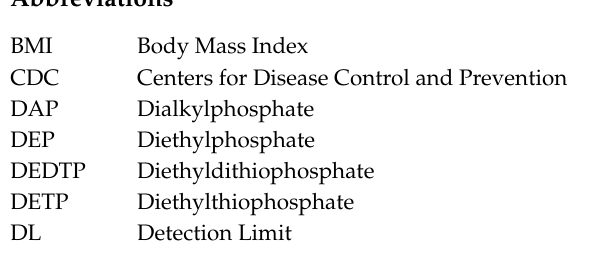
Figure S1: Time trends in urinary DMP metabolites in adults from 1999 to 2008, Figure S2: Time trends in urinary DEP metabolites in adults from 1999 to 2008, Figure S3: Time trends in urinary DMTP metabolites in adults from 1999 to 2008, Figure S4: Time trends in urinary DETP metabolites in adults from 1999 to 2008, Figure S5: Time trends in urinary DMDTP metabolites in adults from 1999 to 2008, Figure S6: Time trends in urinary DEDTP metabolites in adults from 1999 to